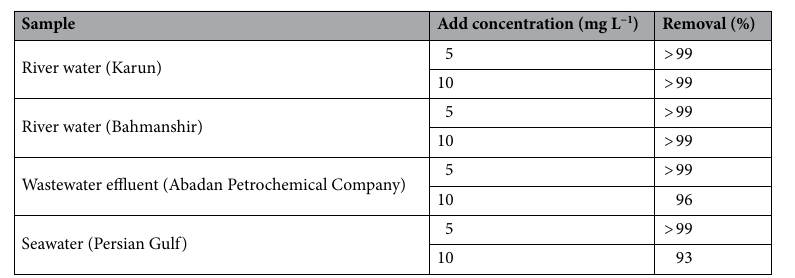
Table 5. Removal of Pb(II) from various water and wastewater samples using proposed method.